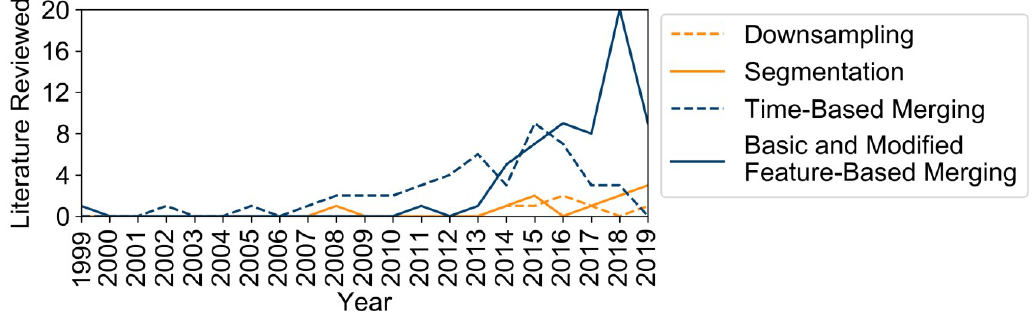
Figure 11. Trends in basic time series aggregation (TSA) methods for energy system models (ESMs) based on the major approaches presented in Section 3.